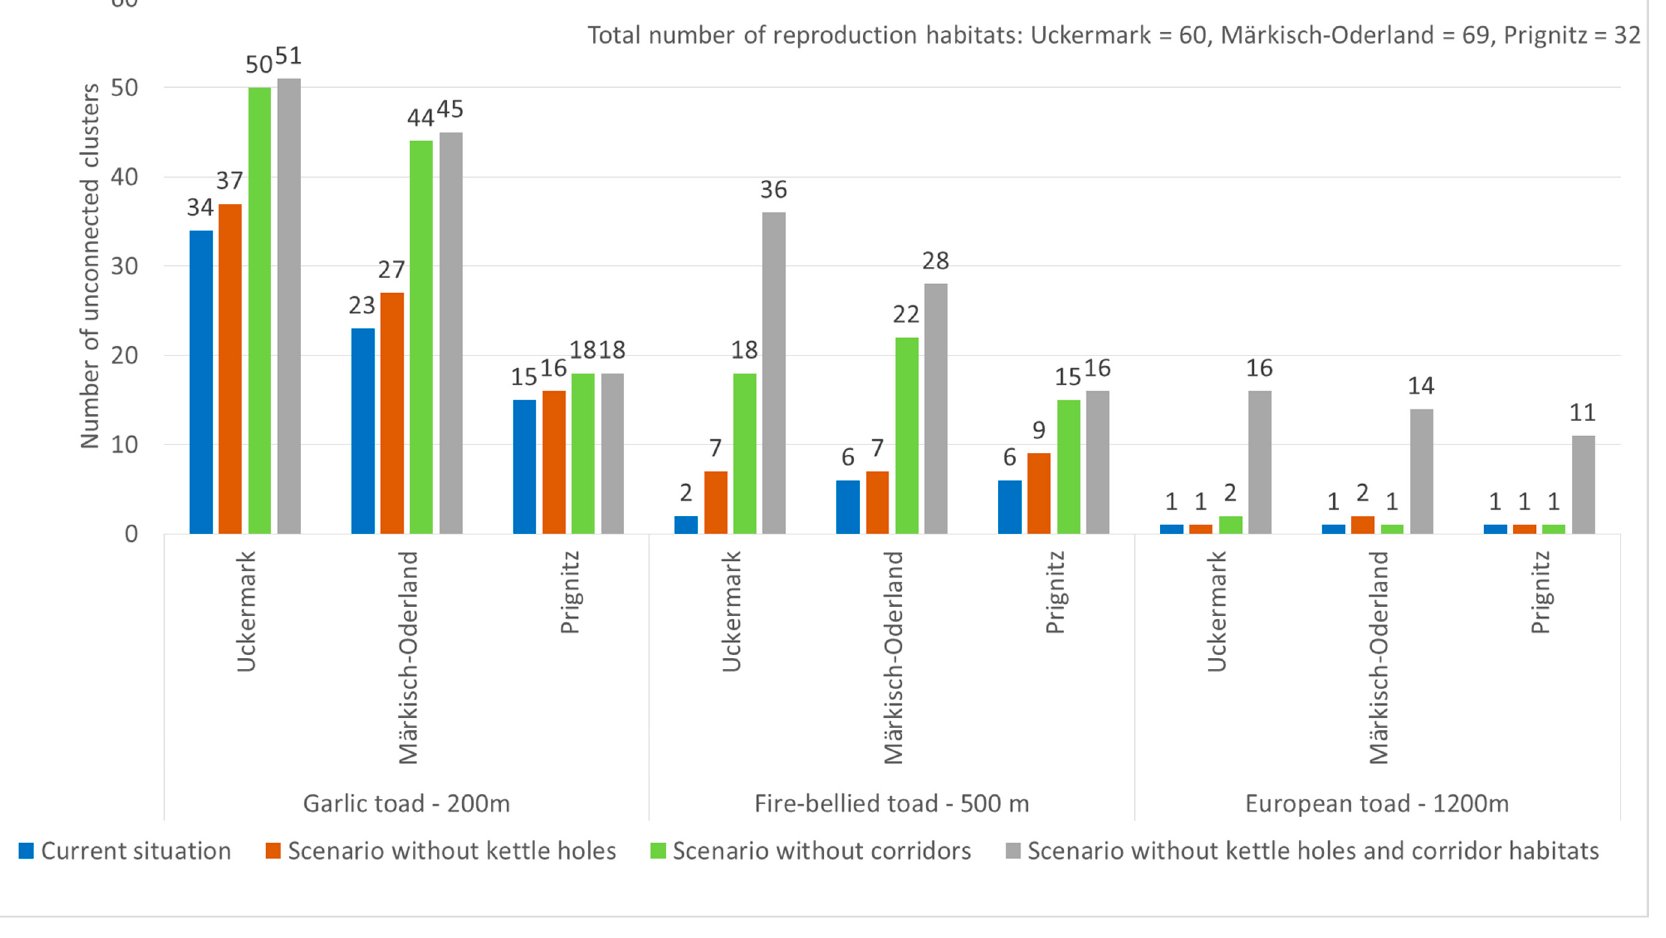
Figure 5. The number of amphibian habitat clusters, indicating the state of the functional connectivity for the three indicator species (garlic toad (range of 200 m), fire-bellied toad (500 m), and European green toad (1200 m)) at the current state and for the three scenarios (i) without corridors, (ii) without kettle holes, and (iii) without kettle holes and corridor habitats.